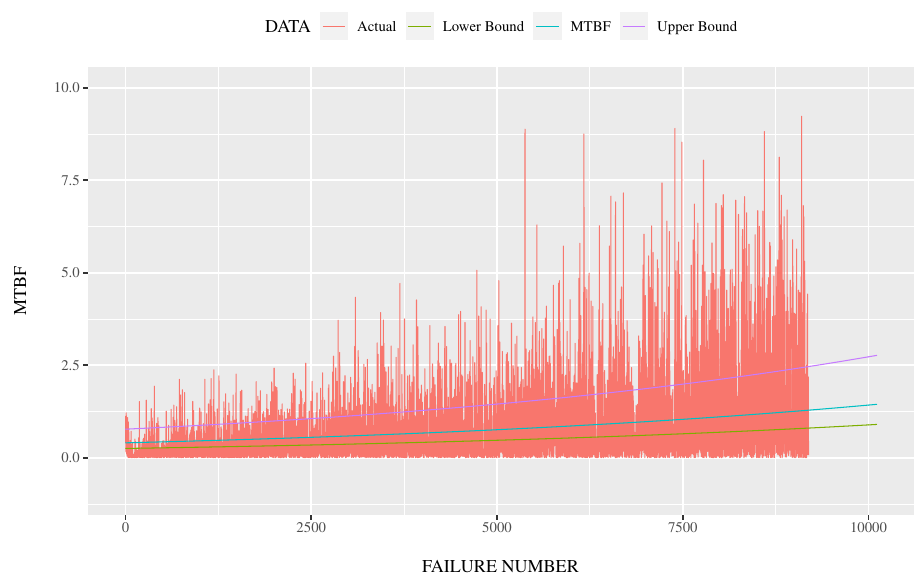
Figure 8. The estimated upper and lower confidence limits for the MTBF c in actual fault big data in the case of the Moranda